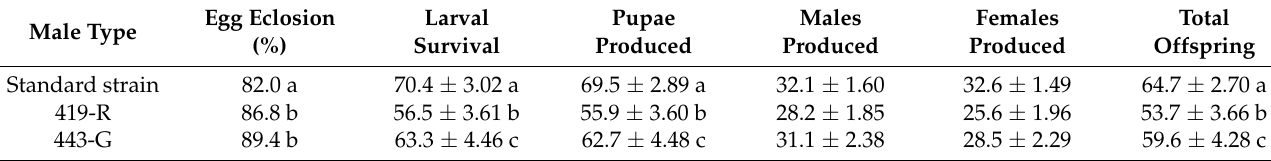
Table 1. Mean ( ± ) s.e. of biological attributes of three strains of Anastrepha ludens. Different letters represent significant differences (post hoc contrast tests, and Tukey’s HSD for egg eclosion). No letters indicate that there was no significant difference in that attribute according to male type. Egg eclosion: number of neonate larvae/total eggs incubated (%); Larval survival: number of 3rd instar larvae; Pupae produced: number of larvae transformed to pupae; Males, Females produced: number of adults of each sex that emerged from the pupae; Total offspring: sum of males and females